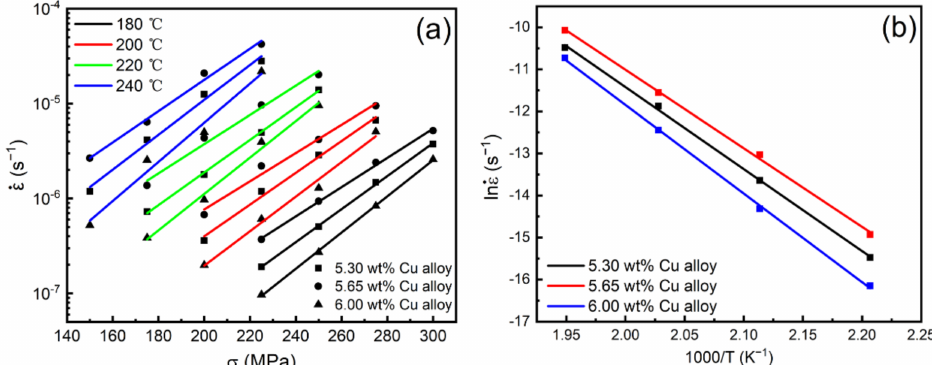
Figure 7. ( a ) The steady creep rate (logarithmic scale) as a function of applied stress (logarithmic scale) of three Al–Cu–Mg–Ag alloys at 180 ◦ C, 200 ◦ C, 220 ◦ C and 240 ◦ C. ( b ) Variation of the steady creep rate (logarithmic scale) with the reciprocal of the temperature of three Al–Cu–Mg–Ag alloys at 225